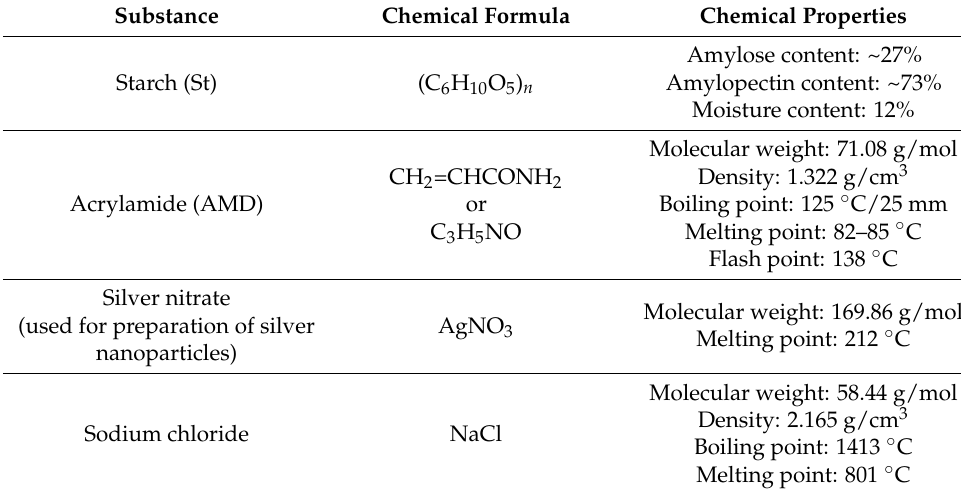
Table 1. Materials used for radiation-induced graft copolymers